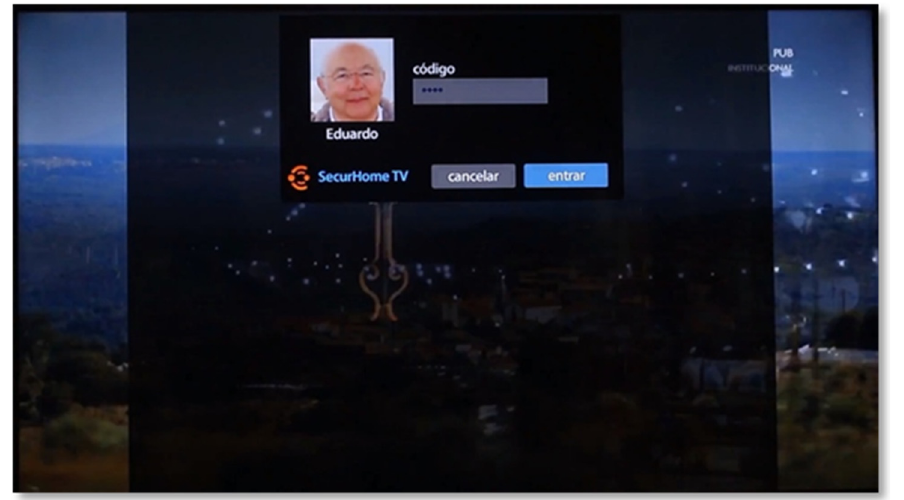
Figure 3. SecurHome TV application login.